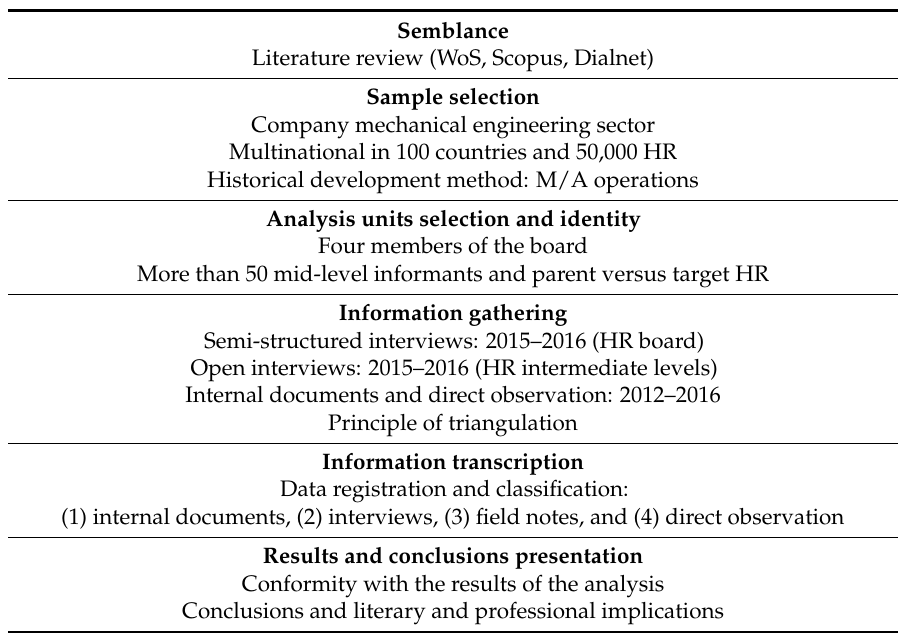
Table 1. Case study